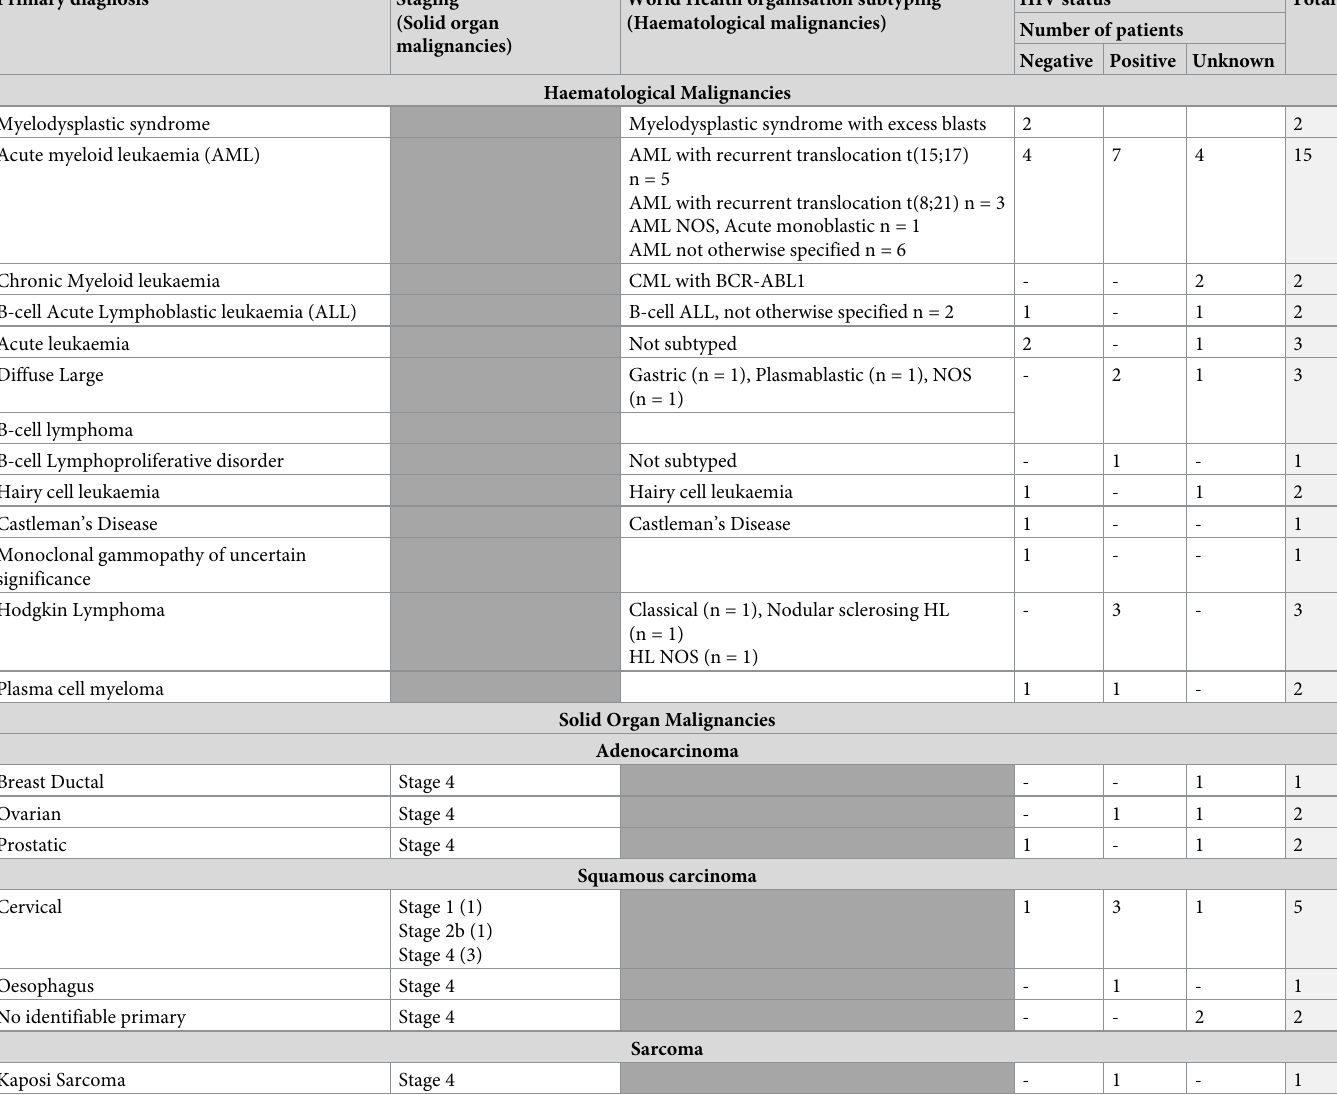
Table 4. Underlying malignancies present in patients with diagnostic features of a DIC.